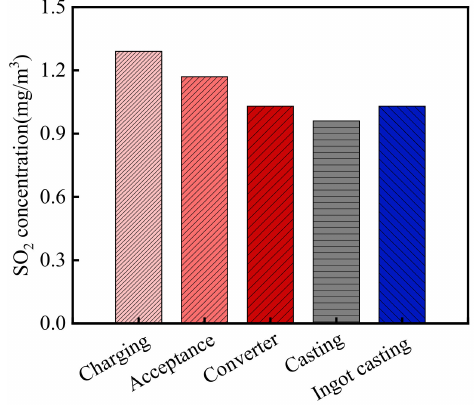
Figure 4. SO 2 concentration in the